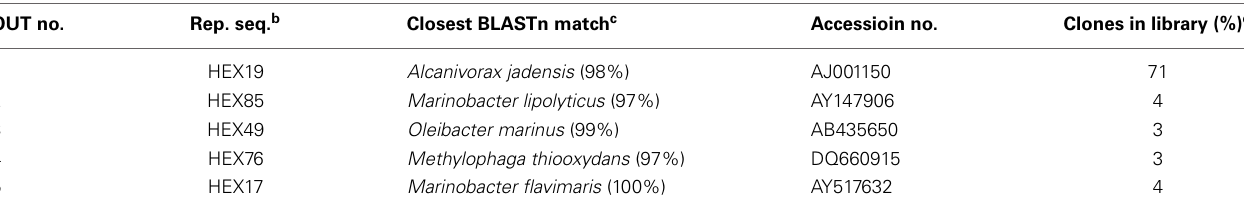
Representative sequence for each OTU. Singleton sequences are listed in Supplementary Table 1 . c Results are to the closest type strain; percentage similarity shown in parentheses.